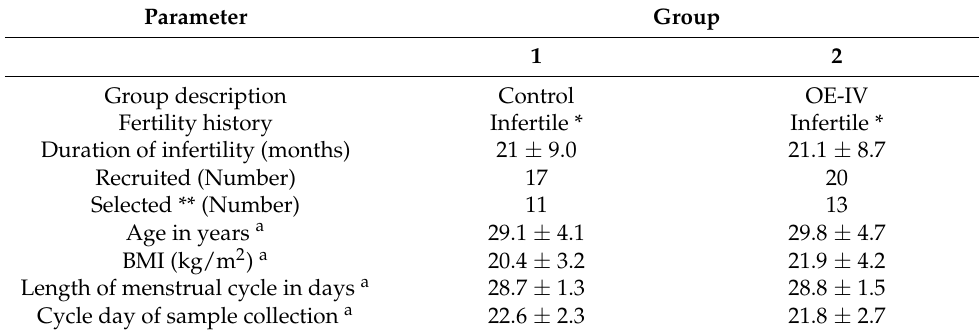
Table 2. Summary of patients’